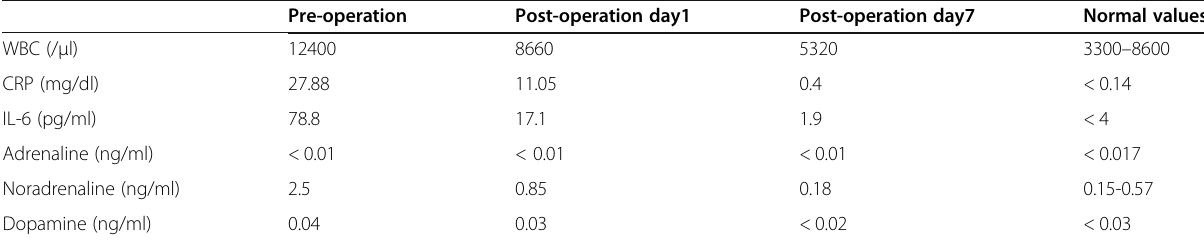
Table 1 Laboratory data pre-and post-operation